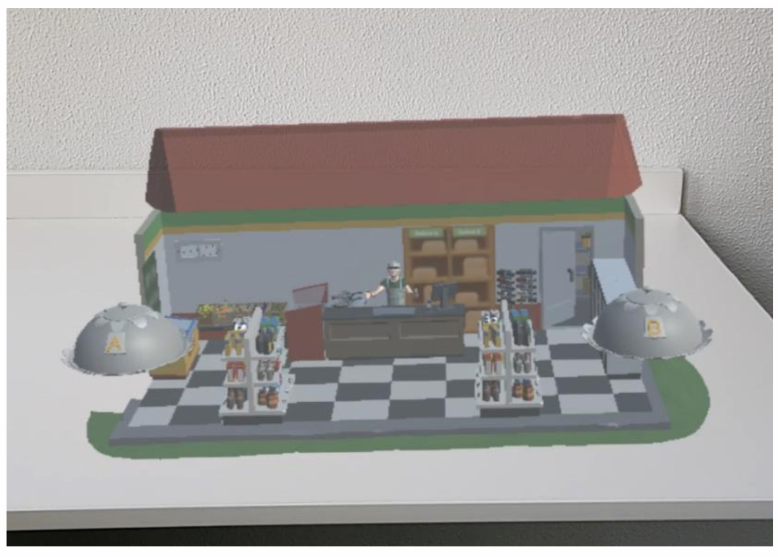
Figure 2. Sample impression Act 1.